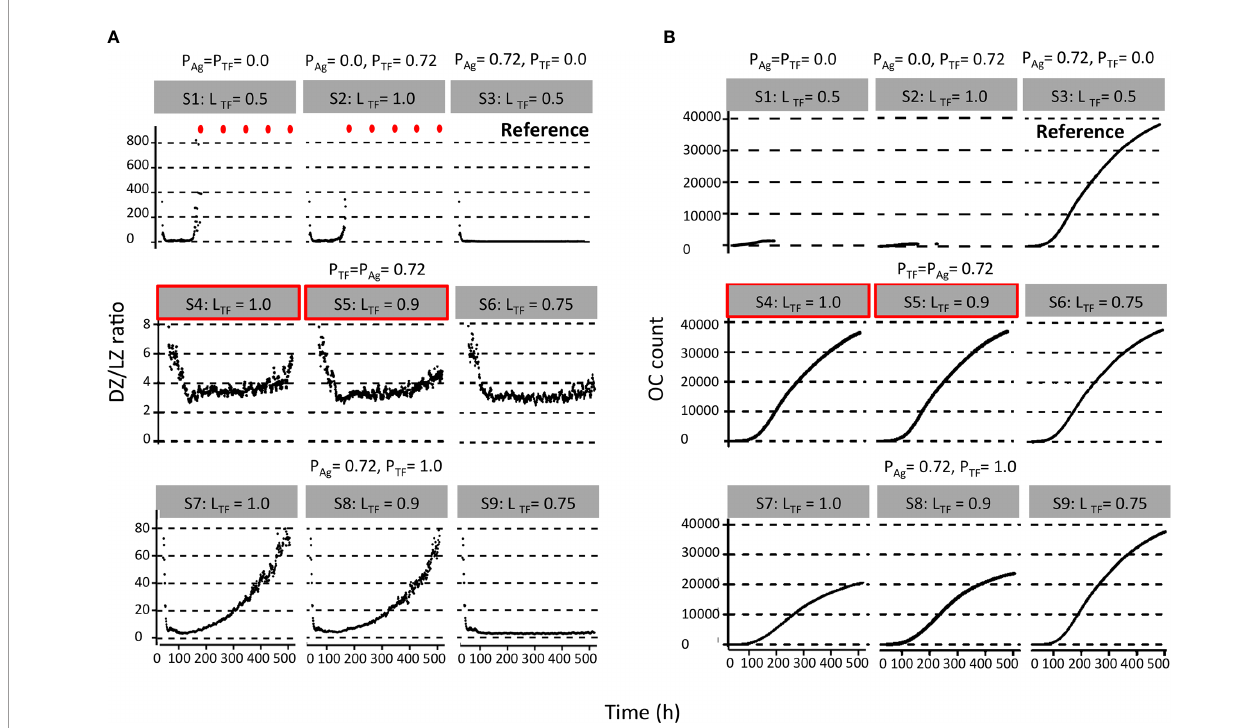
FIGURE 3 | Results from fi rst set of simulations ( Table 2 ). (A) DZ-to-LZ ratio and (B) accumulated OCs during the GC reaction. The probability of asymmetric division (P) is indicated above the gray box, and simulation number and polarity levels (L) are shown in the gray box. Red dots indicate DZ-to-LZ ratio values of in fi nity. First row of plots corresponds to (left column) symmetric division of Ag and TFs, (middle column) symmetric division of Ag and asymmetric division of TFs, and (right column) symmetric division of TFs and asymmetric division of Ag. Second row of plots corresponds to asymmetric TF division only if mode of Ag division is asymmetric. Red boxes indicate parameters that are closer to biological results. Third row of plots corresponds to always asymmetric TF division regardless of mode of Ag division.